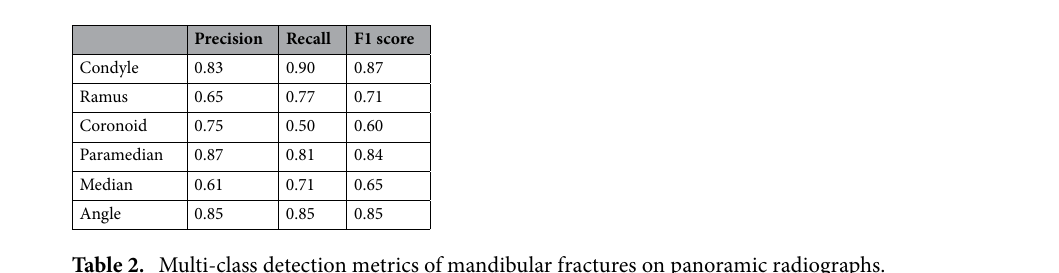
Table 2. Multi-class detection metrics of mandibular fractures on panoramic